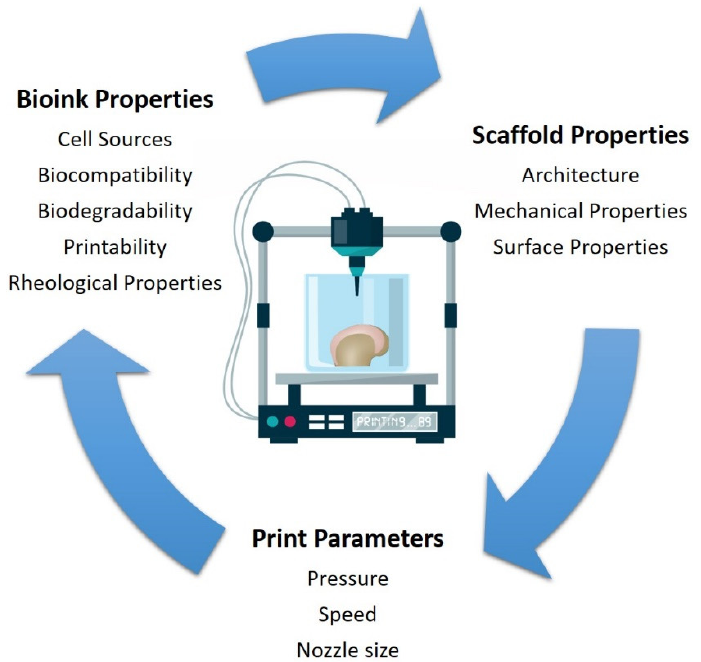
Figure 2. Main bioink properties, construct properties, and print parameters for extrusion-based 3D bioprinting for cartilage tissue engineering applications.